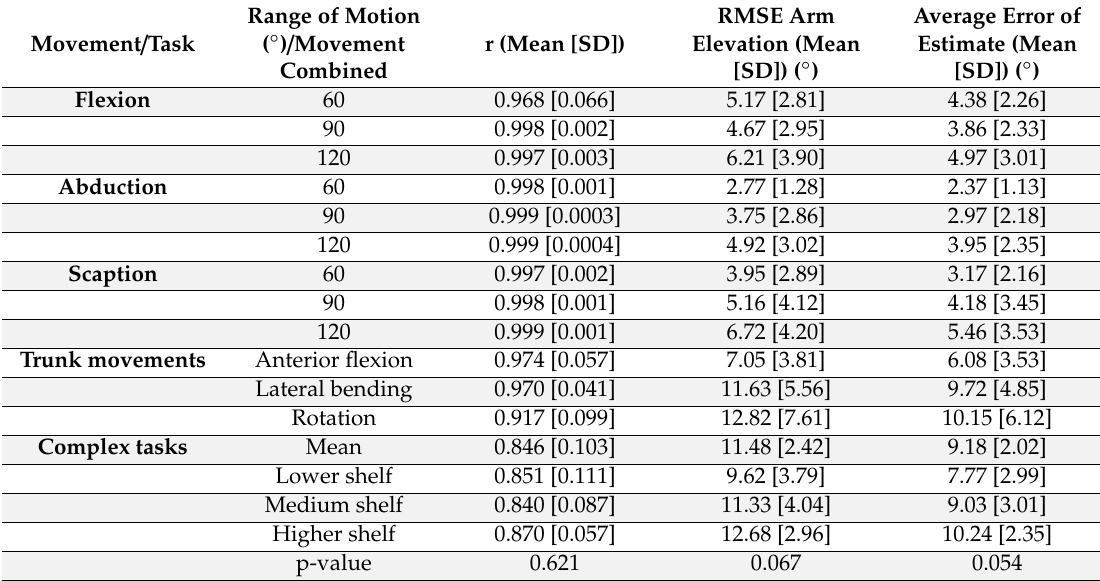
Table 1. Correlation coe ffi cient, root-mean-square error, average error of estimate and absolute error for simple and complex movements.